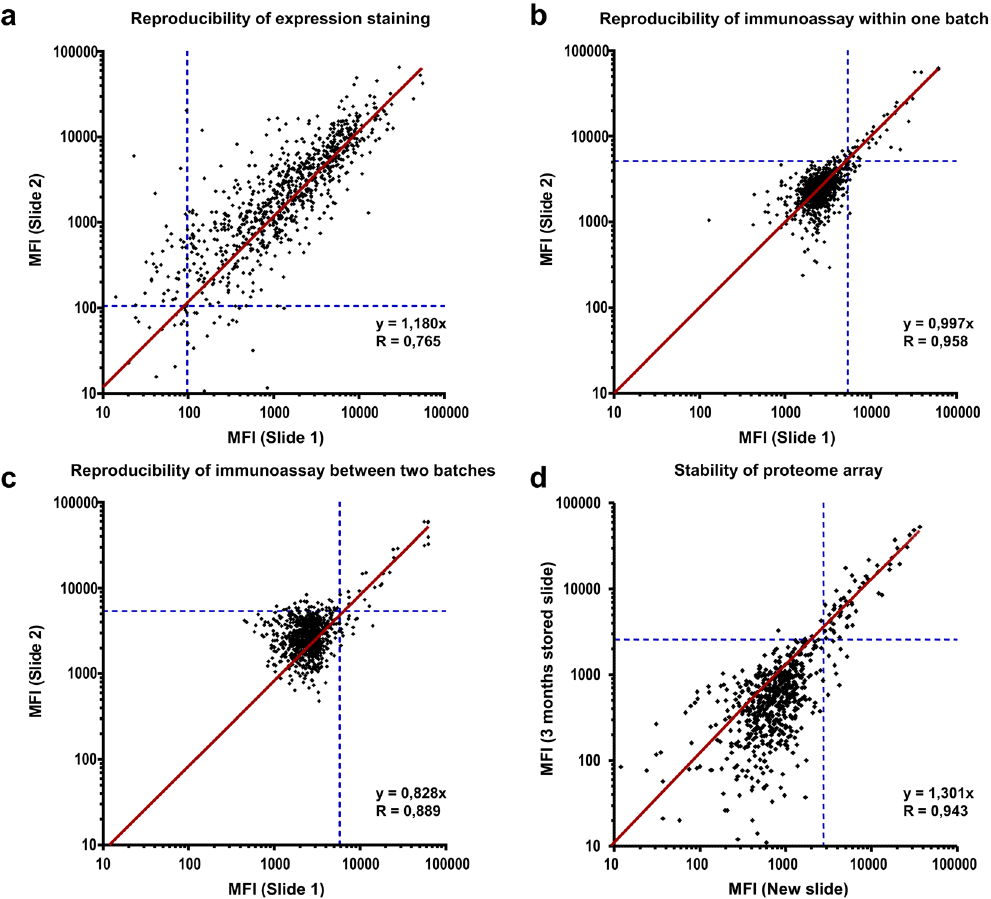
Figure 4. Reproducibility and stability of analyses on Ct whole-proteome microarrays. Correlation of MFI values obtained in two independent experiments was determined by linear regression analysis (forced through the origin) and is expressed by the slope and Pearson’s correlation coefficient (r). Cut-offs are highlighted by dashed blue lines. ( a ) Expression staining using antibodies against fusion tags of the proteins was replicated on two slides from the same production batch. Each dot represents one Ct protein with anti-V5 MFI values from two independent experiments. ( b ) Repetition of an immunoassay for the same pool of five sera on two slides produced within the same batch. ( c ) Same as b, with slides from two different production batches (same pool as in panel b). ( d ) Repetition of an immunoassay for the same pool of five sera on two slides (different pool from panels b and c). One Immunoassay was performed shortly after production of the microarray and one slide was stored for a time period of 3 months before the assay was